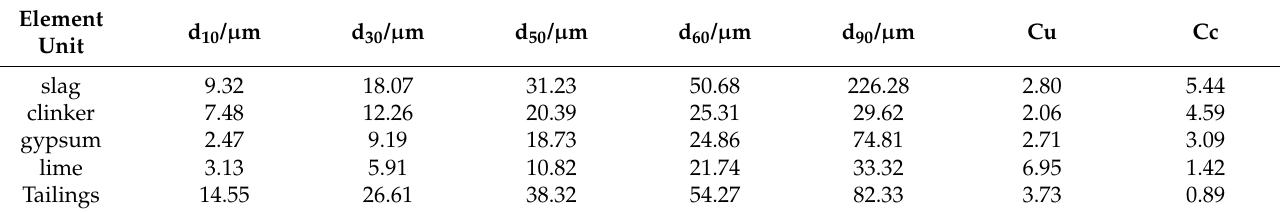
Table 1. Grain size distribution of NCM and tailings.